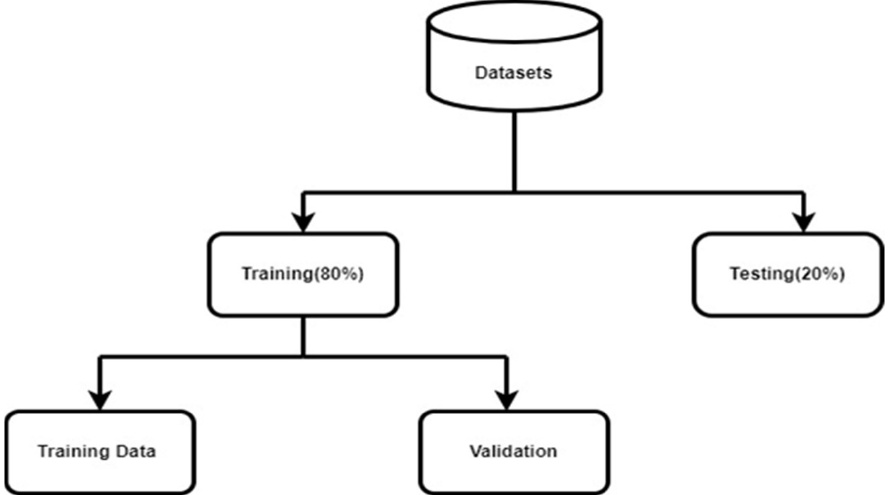
Figure 7. ( a ) Cracked concrete wall images ( b ) Non-cracked concrete wall images.